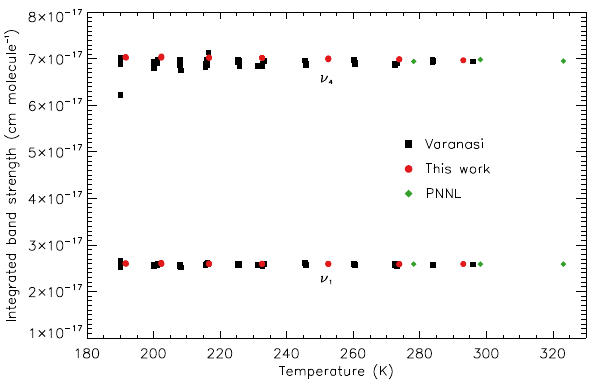
Figure 3. Integrated band strength as a function of temperature for the new, Varanasi, and PNNL cross-section datasets over the wavenumber ranges 810–880 and 1050–1120cm − 1